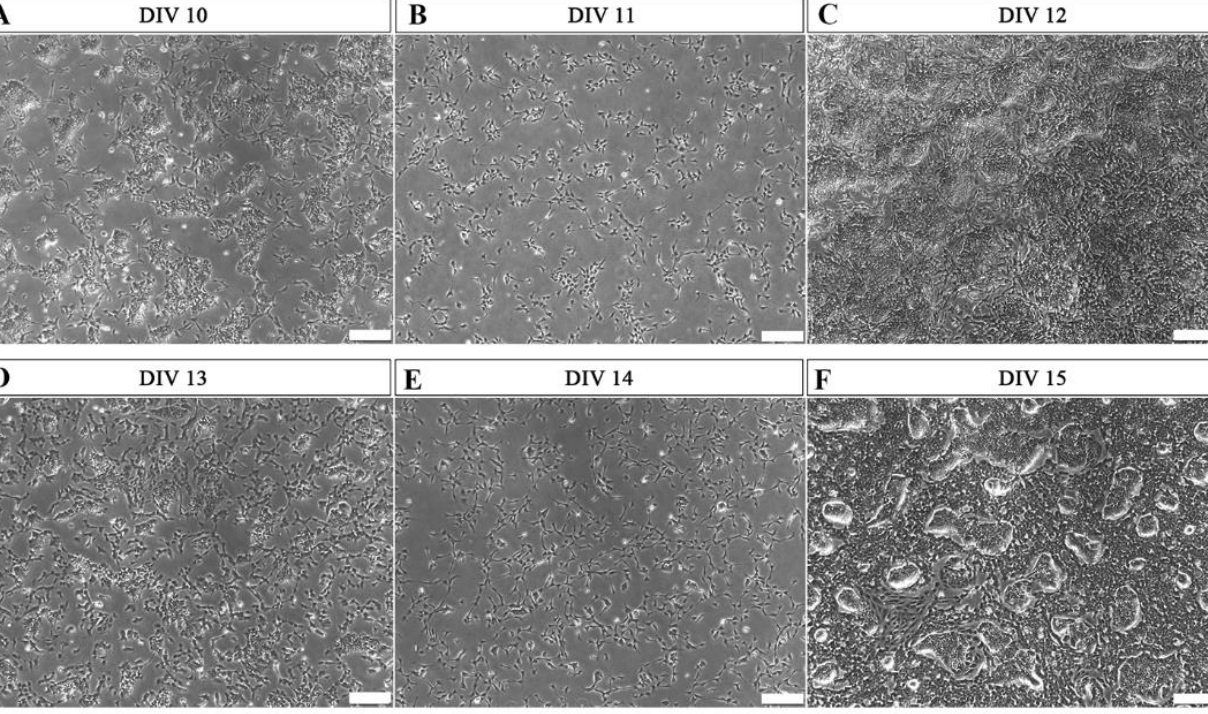
Figure 1. Representative phase-contrast photomicrographs of cells undergoing differentiation from hiPSCs to hiPSC-immatureSCs. Matrigel coating was used during this period. ( A , D , G ) show the morphology of the differentiating cells at 60 – 70% confluence, after 10 days in vitro (DIV 10) ( A ), DIV 13 ( D ), and DIV 16 ( G ), respectively. After this, cells were alternatively passaged to a lower cell density of 2 × 10 5 per well in a 6-well plate (( B ) — DIV 11, ( E ) — DIV 14, ( H ) — DIV 17) or continuously cultured, without splitting, in high cell density (( C ) — DIV 12, ( F ) — DIV 15, ( I ) — DIV 20). DIV = days in vitro. Scale bar: 200 µm. Immunocytochemistry (ICC) was used to further characterize these differentiated cells at DIV 20 using antibodies against CDH19, SOX10, p75 NTR , GAP43, GFAP, S100B, and GALC (Figure 2). The ICC results demonstrated that the cells were already negative for CDH19, a marker commonly considered to be specific for SCPs (Figure 2A), and positive for Schwann cell markers SOX10, p75 NTR , GAP43, GFAP, S100B, and GALC (Figure 2B).